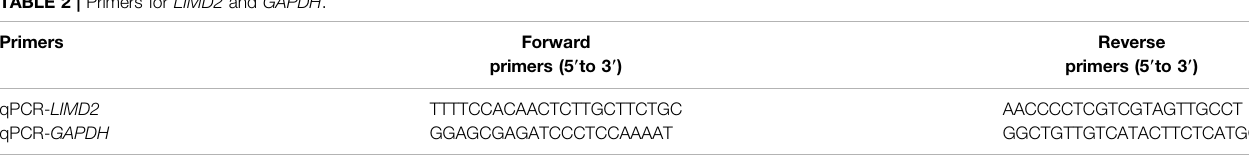
TABLE 2 | Primers for LIMD2 and GAPDH